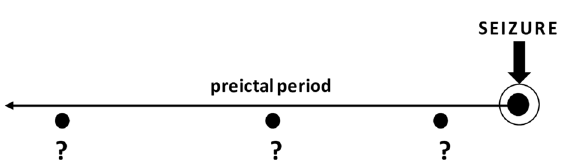
Figure 1. Principle of the analysis of the preictal